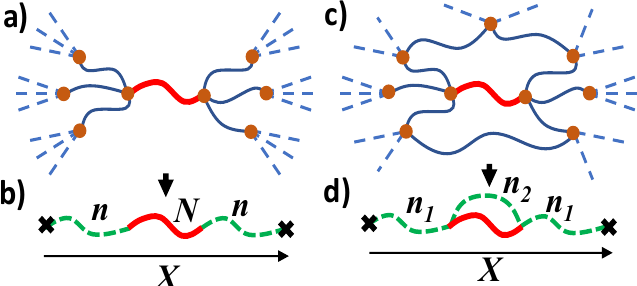
Figure 2. ( a ) The model of perfect network with tree-like connection of network strands (solid curves) and infinite size loops (dotted lines). ( b ) A network strand with N monomers can be considered as a part of the combined chain, connected through two effective chains with n monomers (dashed green curves) to the non-fluctuating background. ( c ) Actual network with finite size loops. ( d ) The combined chain consists of three effective chains. The filled circles and crosses indicate cross-links and nonfluctuating background, respectively. The end-to-end vector of the combined chain X deforms affinely with network